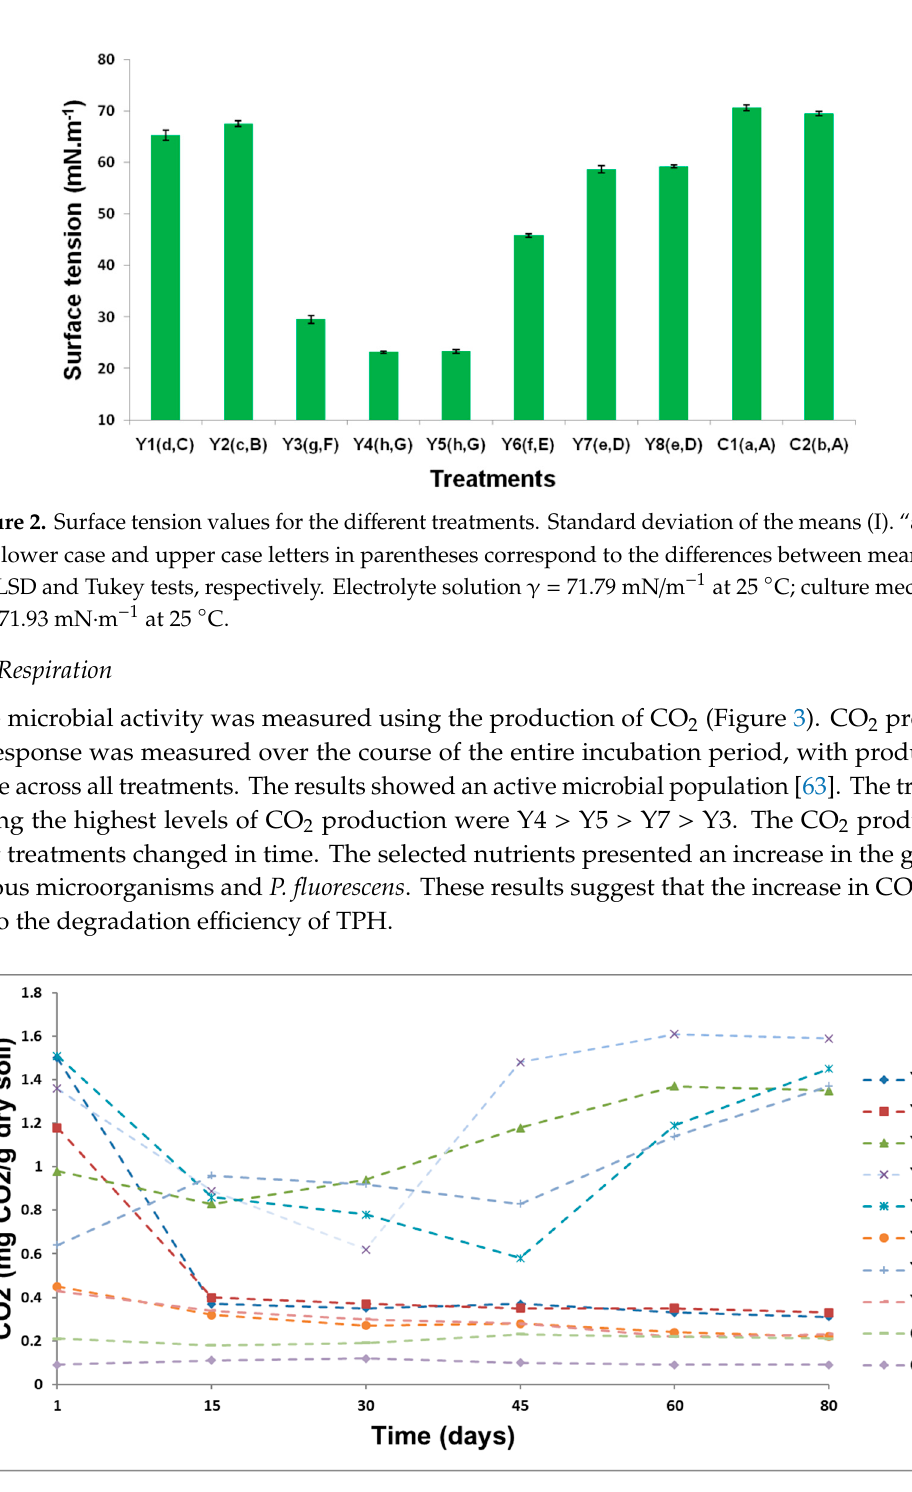
Figure 3. Mean CO 2 release over 80 days.